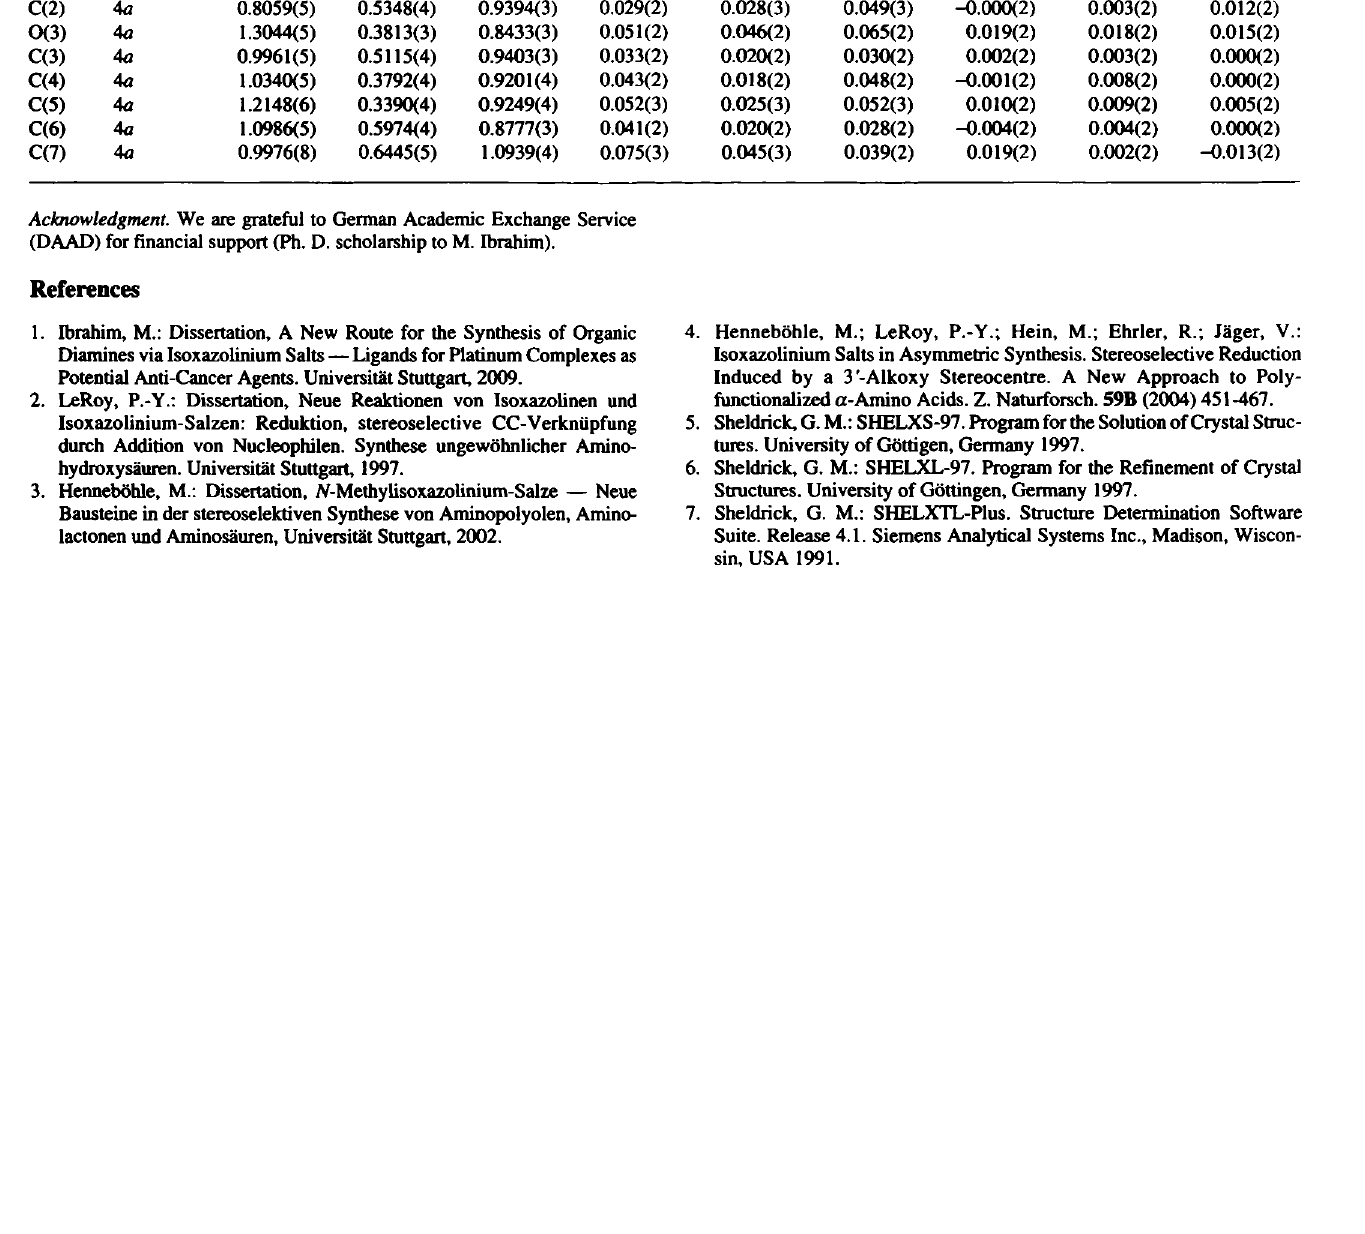
Table 3. Atomic coordinates and displacement parameters (in Â 2